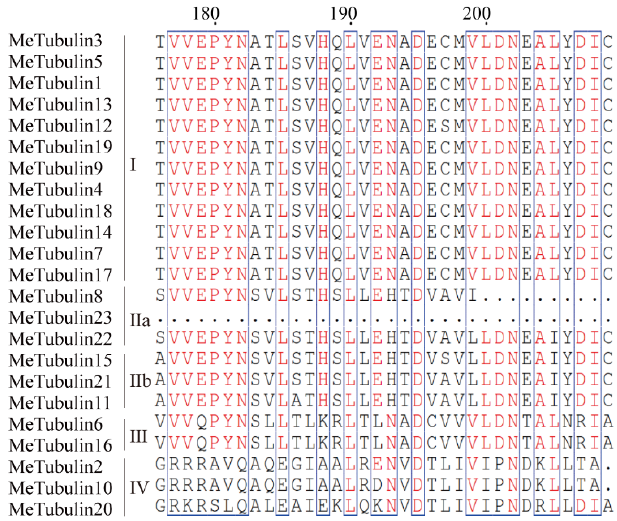
Figure 2. Tubulin domain sequence alignment of MeTubulin proteins. Dots represent gaps, blue frames represent the conserved region, red columns indicate the identical residues, and red letters indicate conserved residues.